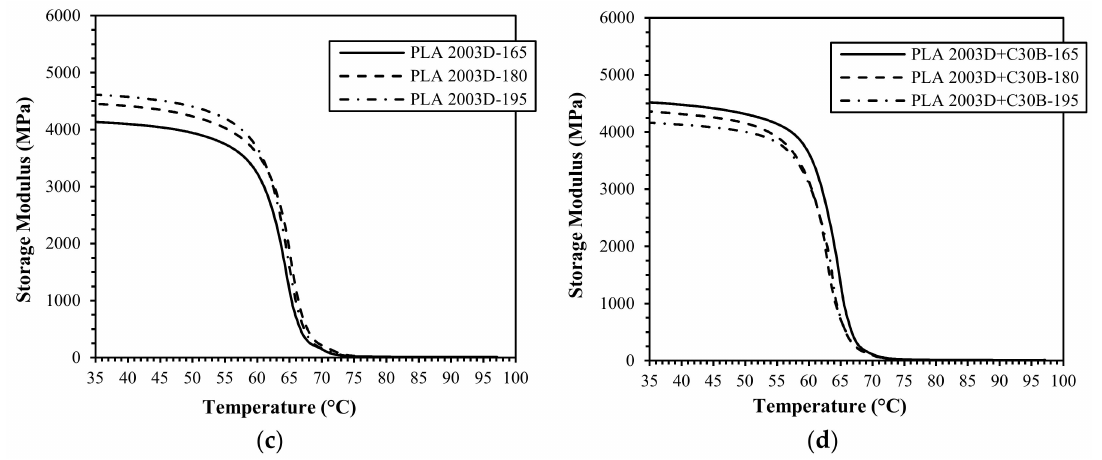
Figure 11. Storage modulus vs. temperature of the 3D printed samples of PLA 4032D ( a ), PLA 4032D+C30B ( b ), PLA 2003D ( c ), and PLA 2003D+C30B ( d ) printed at different temperatures.